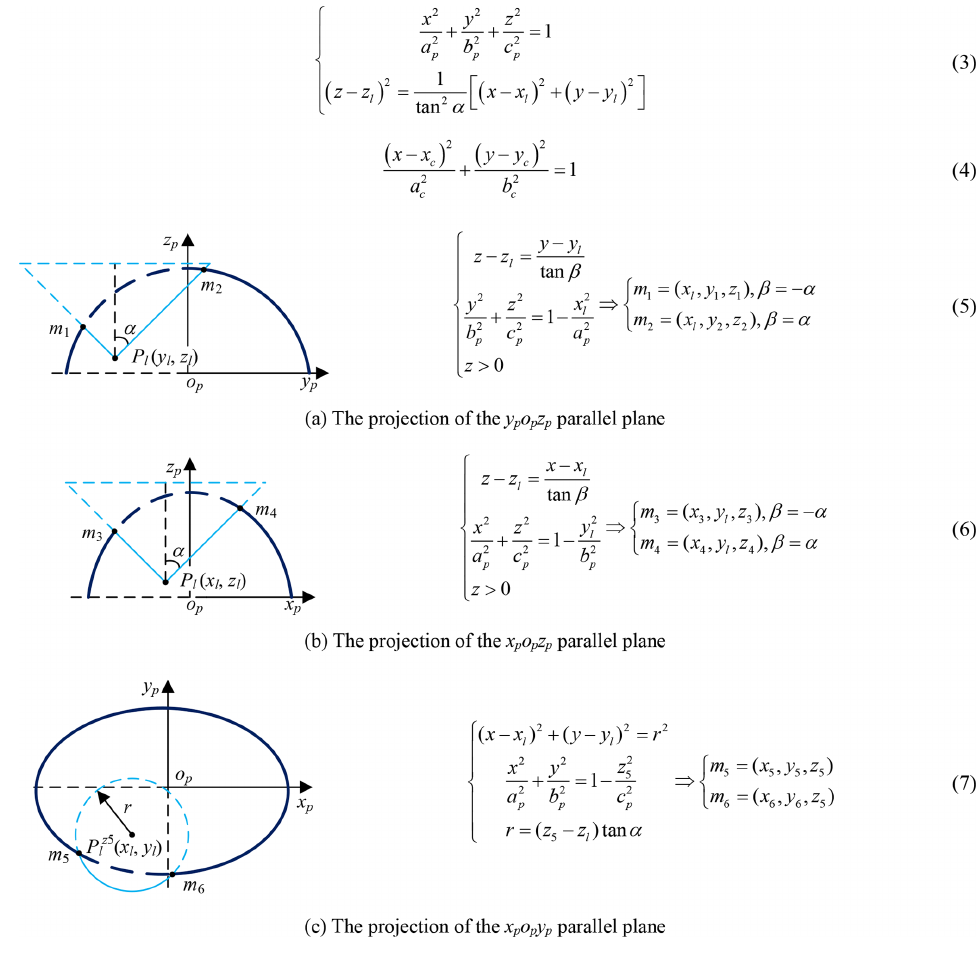
Figure 9. The projection of three planes.